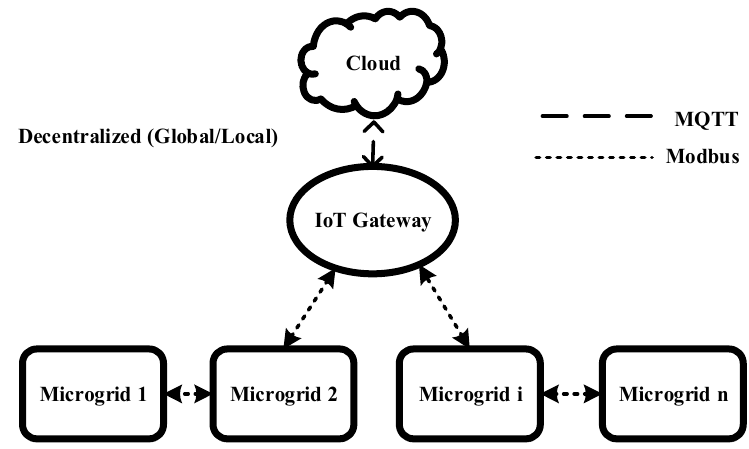
Figure 8. Decentralized communication mode.